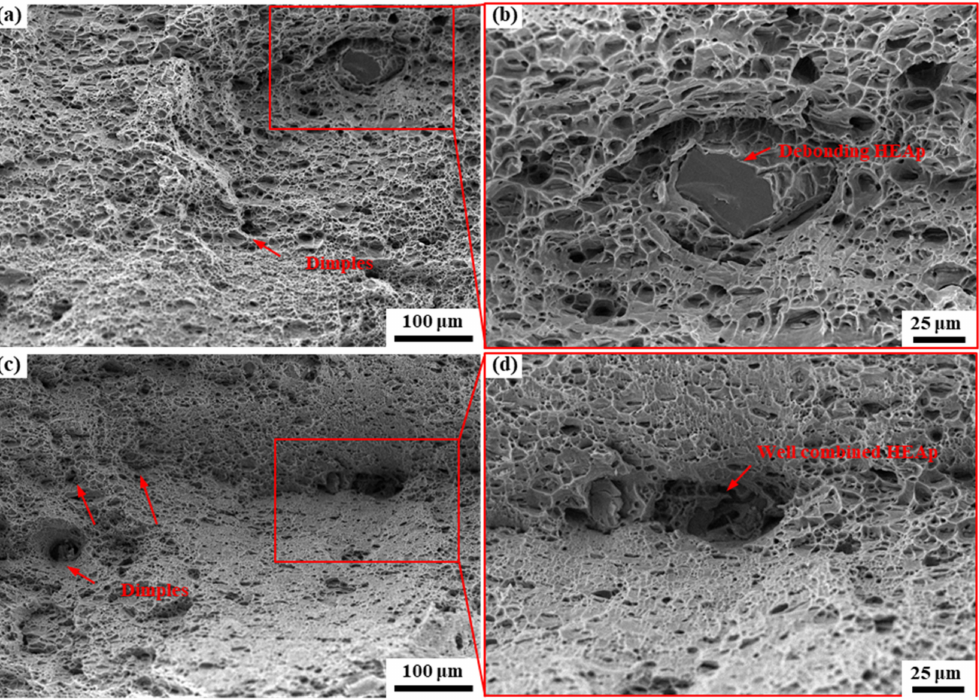
Figure 7. Fracture morphologies of RTR 3 wt% HEAp/AMCs ( a , b ). CR 3 wt% HEAp/AMCs ( c , d ) at 30% rolling reduction ratios.